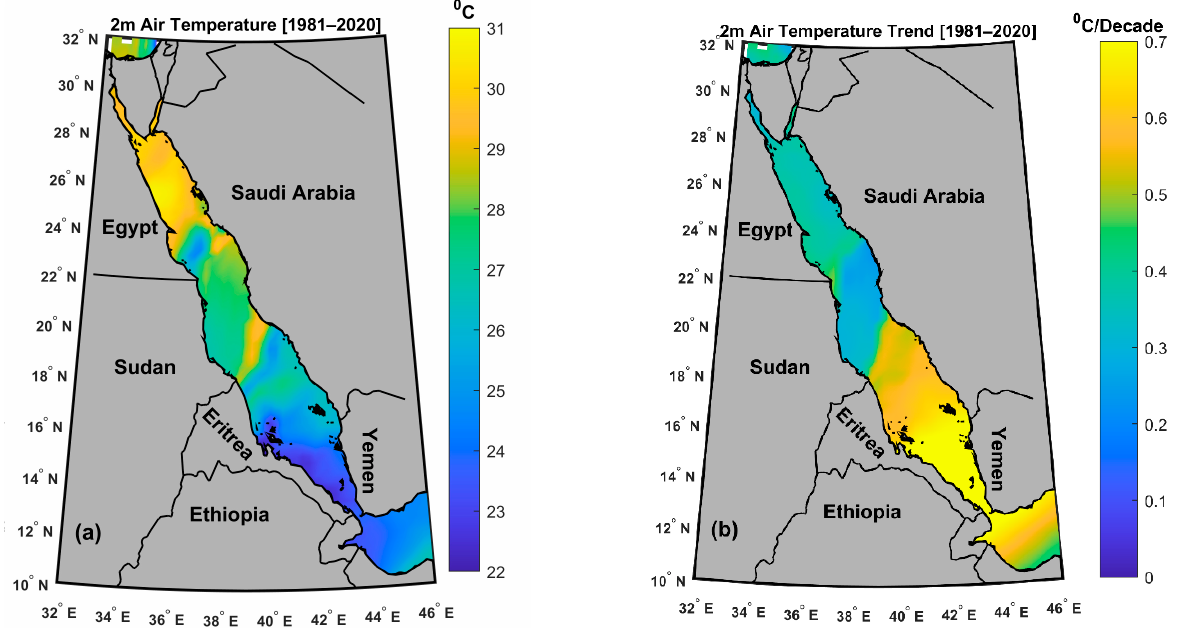
Figure 3. Spatial distribution for ( a ) air temperature at 2 m elevation (°C) and ( b ) mean trend (°C/decade) for the Red Sea from 1981 to 2020.